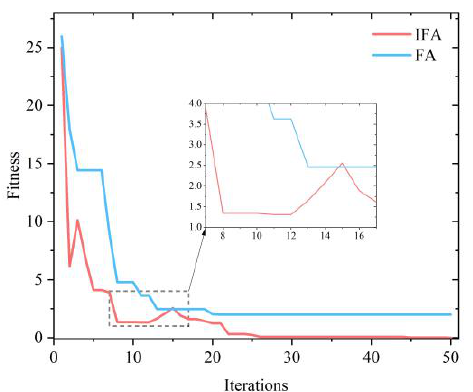
Figure 4. Evolutionary curve of the Rastrigin function using the FA and the